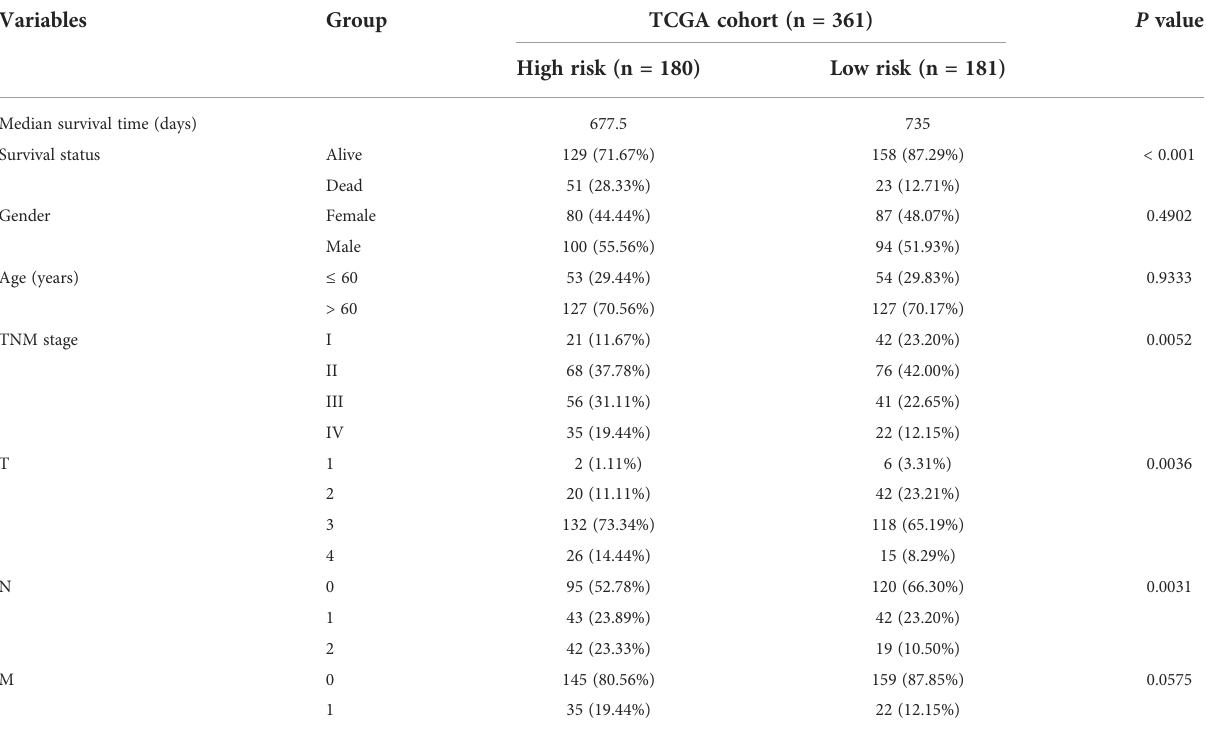
TABLE 1 Baseline characteristics of the patients in TCGA cohort.